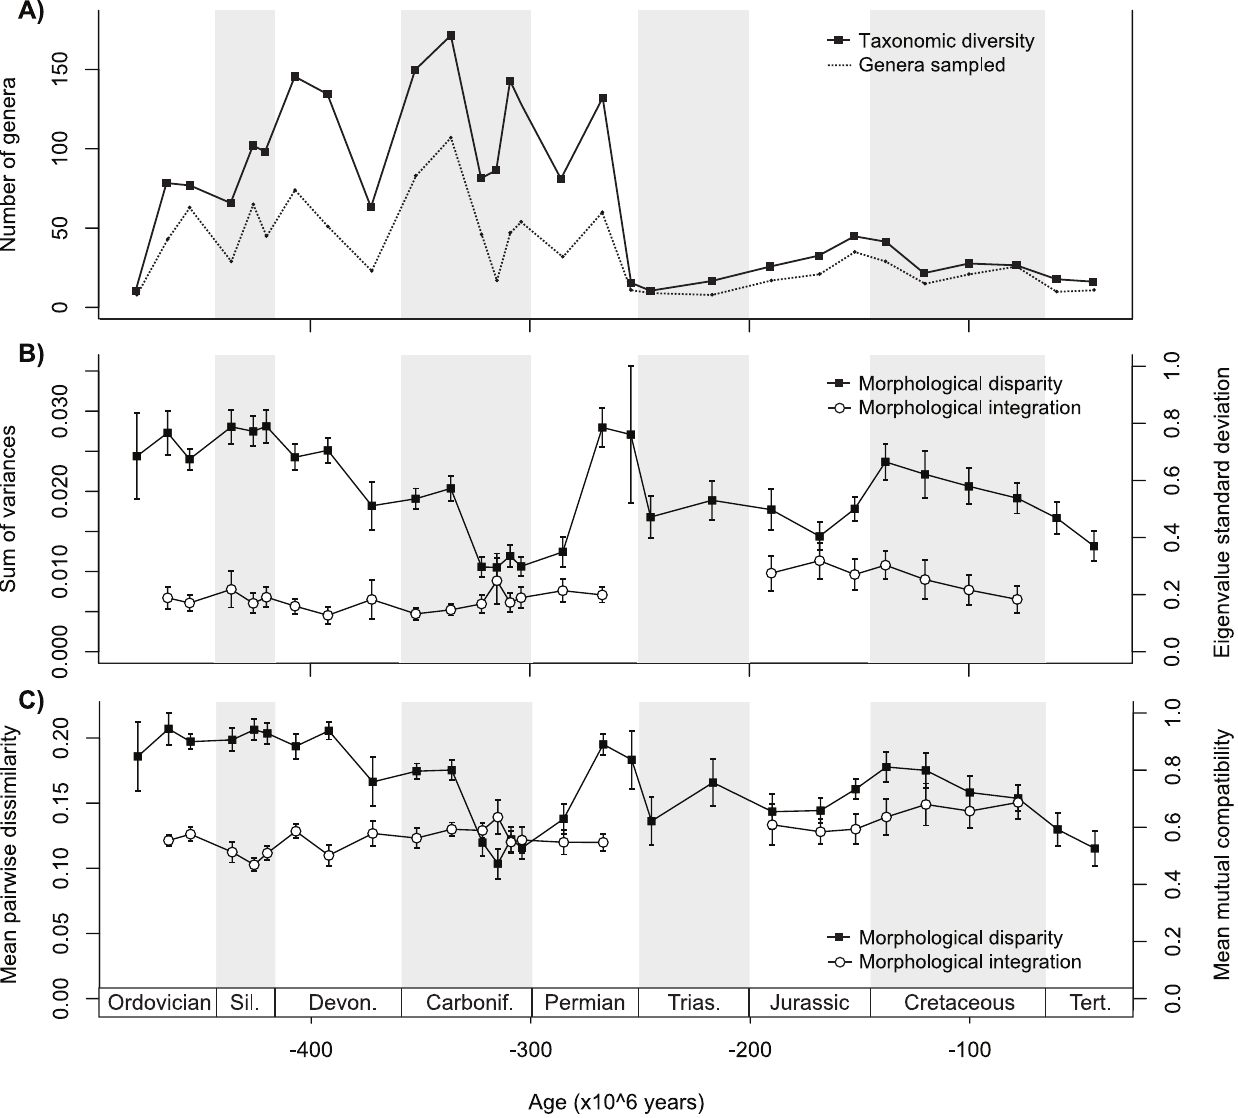
Figure 1. The temporal trajectories of taxonomic diversity, morphological disparity and morphological integration of Phanerozoic crinoids. (A) Number of genera known and number of species sampled per genus per stratigraphic interval. (B) Disparity measured as the sum of univariate variances; integration measured as the relative standard deviation of the eigenvalues of the correlation matrix. (C) Disparity measured as the mean character dissimilarity; integration measured as mean mutual compatibility. Error bars are bootstrapped standard errors. Because low sample sizes prevent from deriving reliable estimates of correlation matrices (see text), integration values are not presented for Early Ordovician, Late Permian, Triassic, and Cenozoic data. Whether based on the analysis of discrete or continuous variables, variations in the overall degree of integration do not appear to be associated with concomitant changes in disparity.